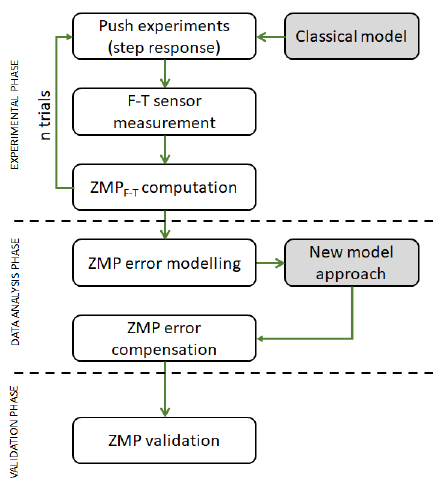
Figure 12. Experimental procedure diagram.